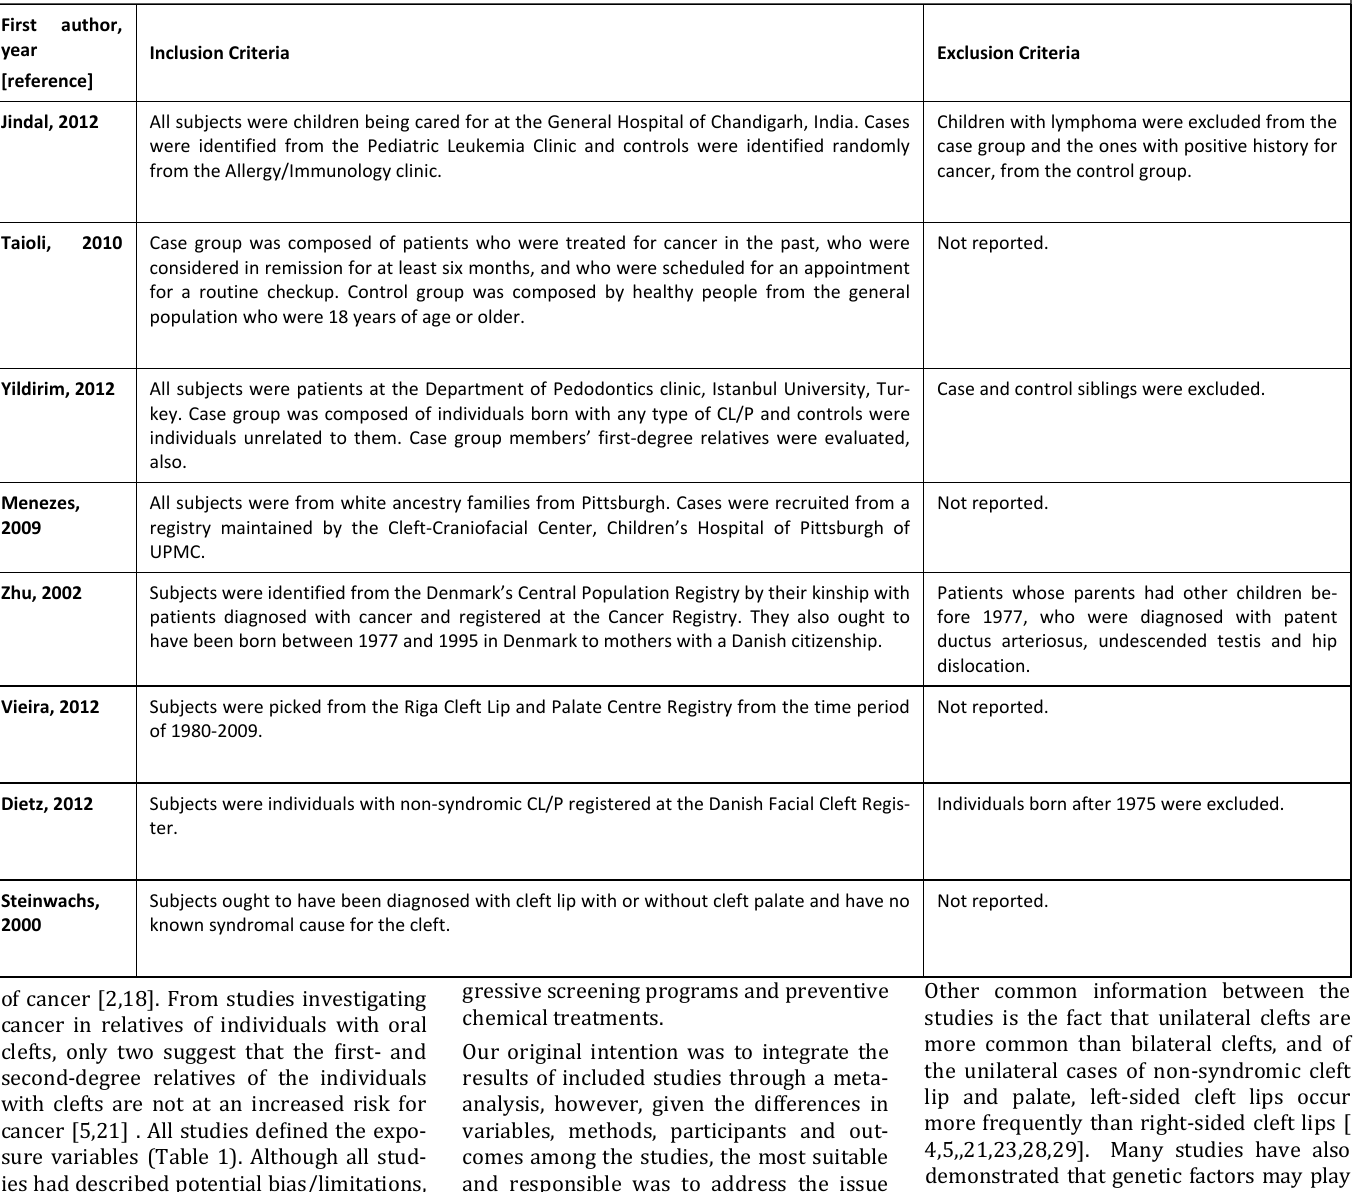
Table 3: Inclusion and exclusion criteria among the eight selected